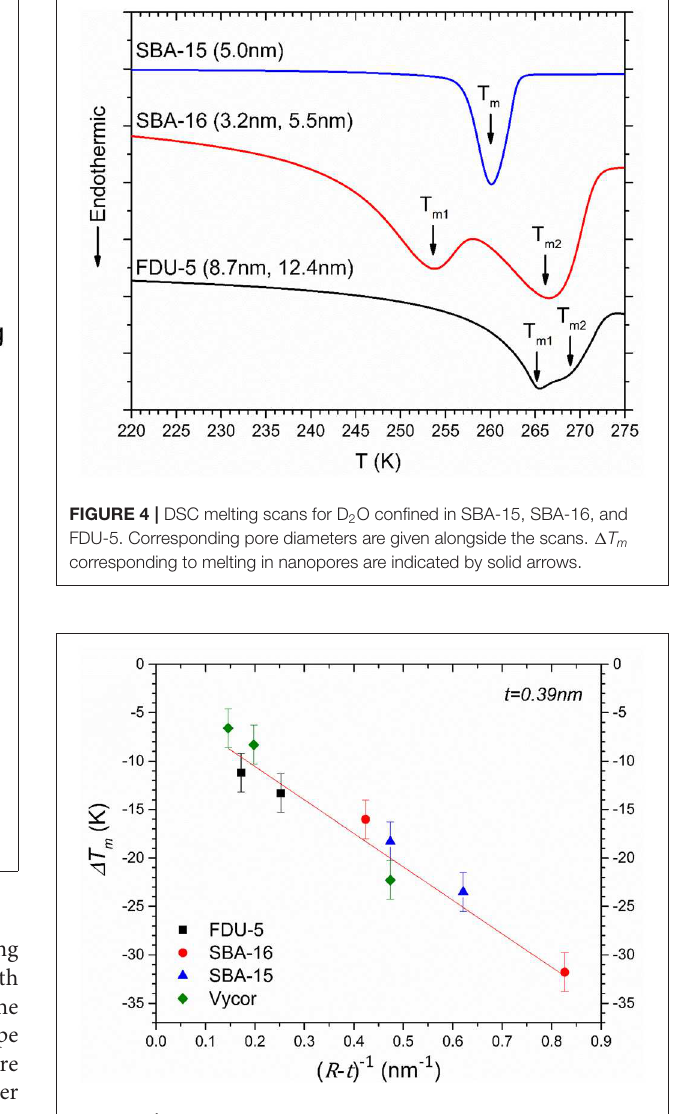
of 1 T g = (cid:0) T gB − T g (cid:1) on the pore size R ( Figure 7 ), in